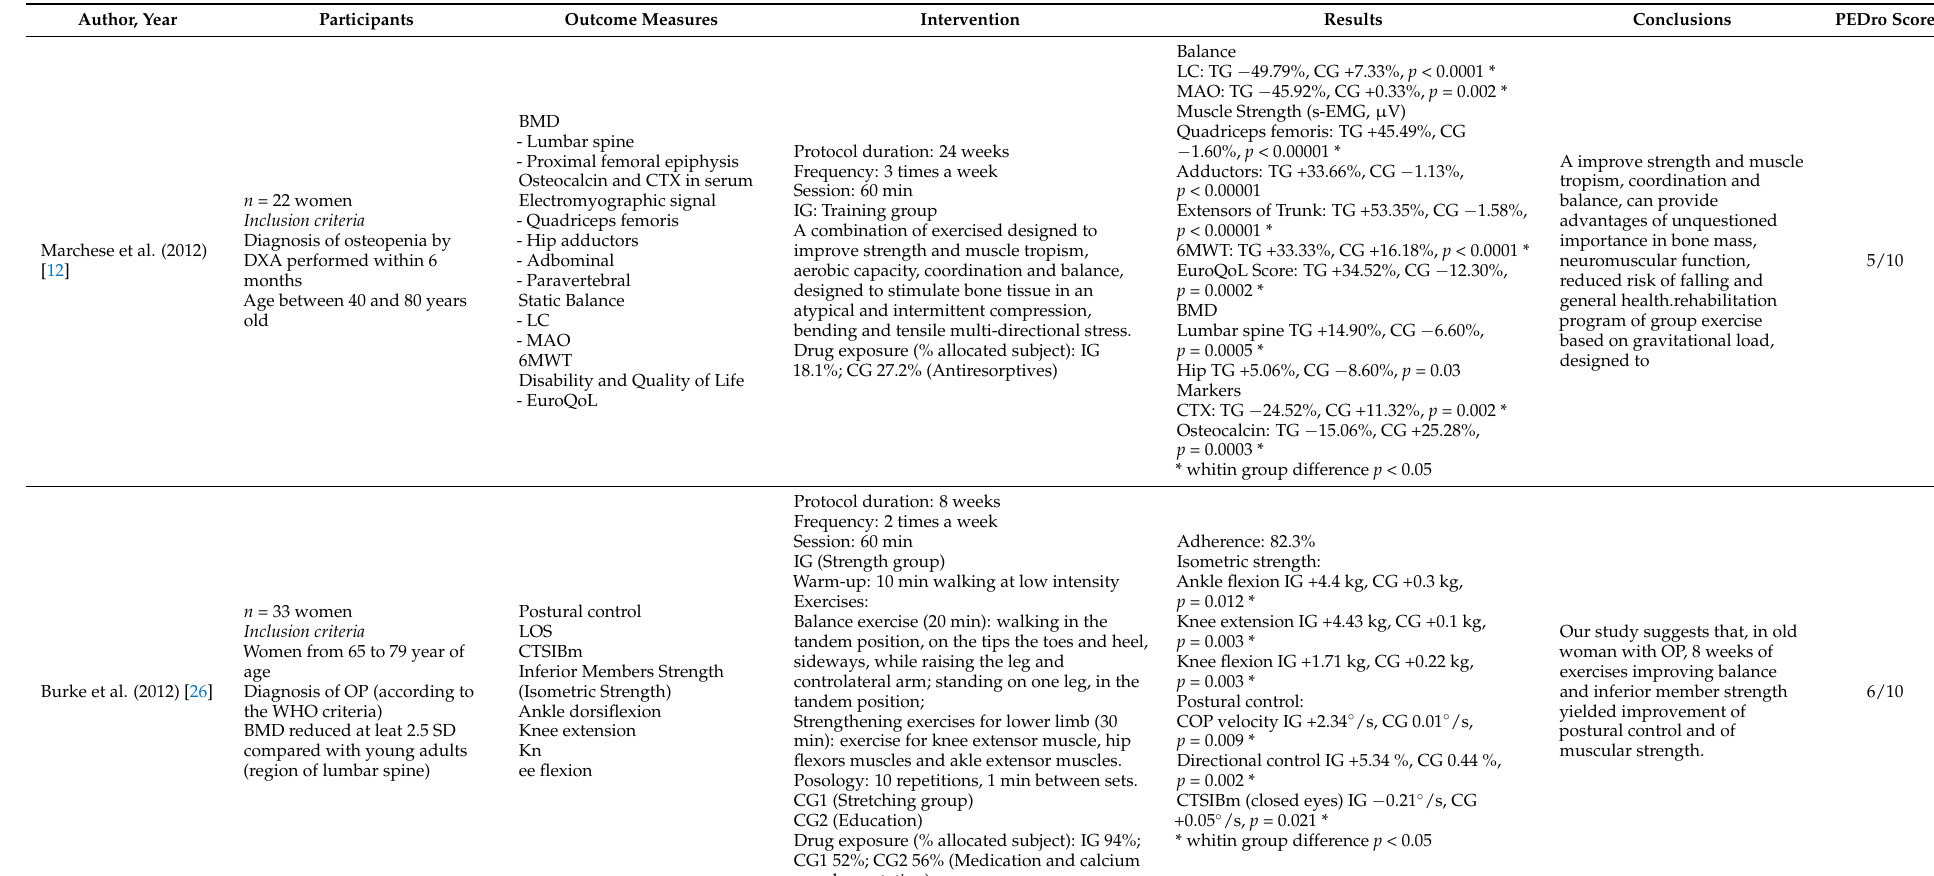
Protocol duration: 24 weeks Frequency: 3 times a week Session: 60 min IG: Training group